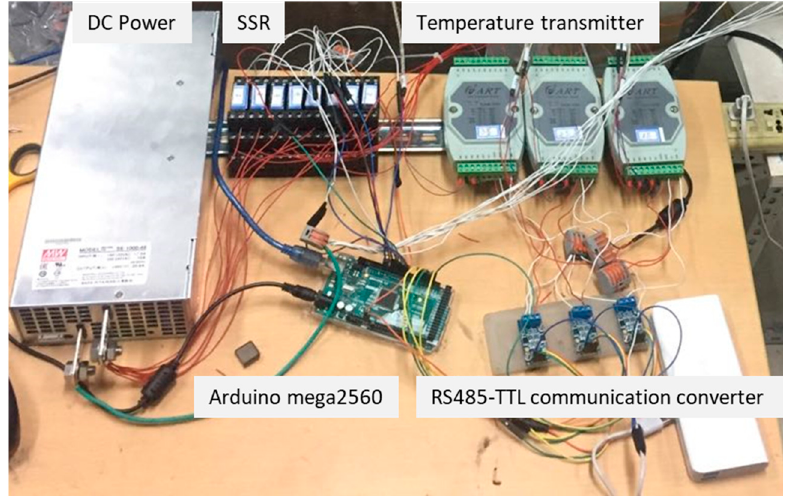
Figure 6. PID control system.